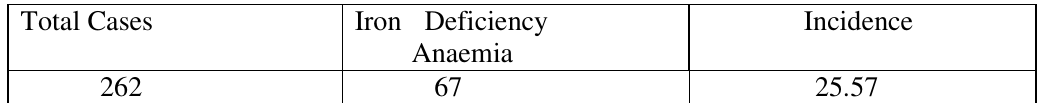
Table-1: Prevalence of Iron Deficiency Anaemia